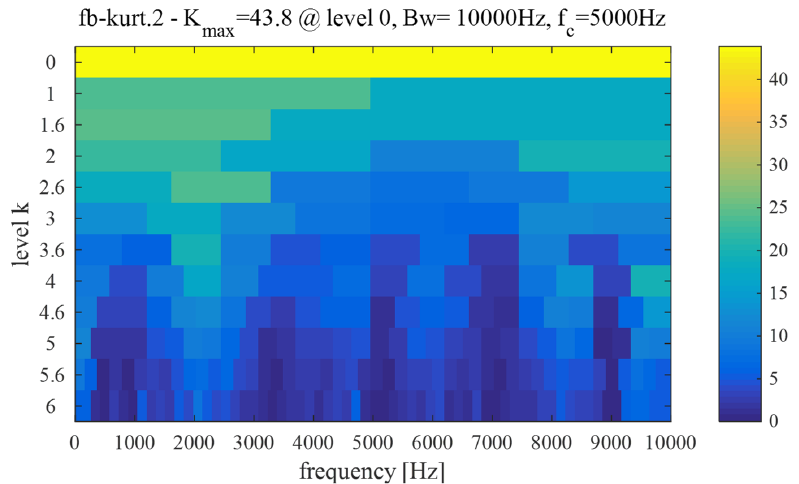
Figure 16. Fast spectral kurtosis figure of the 2056th set of data.